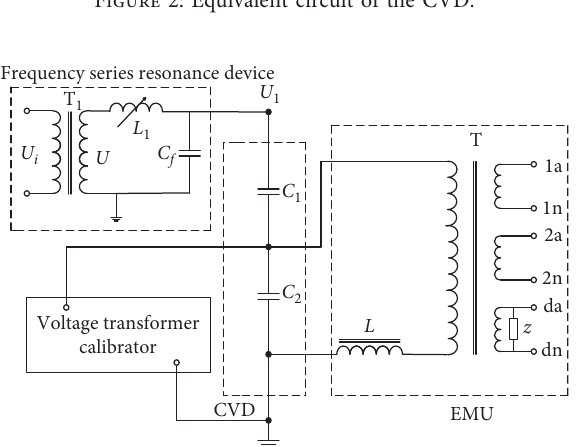
Figure 3: Schematic diagram of voltage measurement of the CVT.